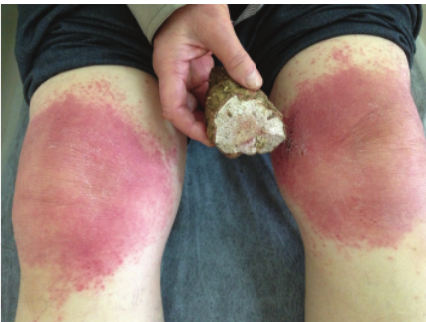
Figure 1: Erythematous, edematous, and mild scaly plaques exceed- ing the application border on the skin and Mandragora Radix.